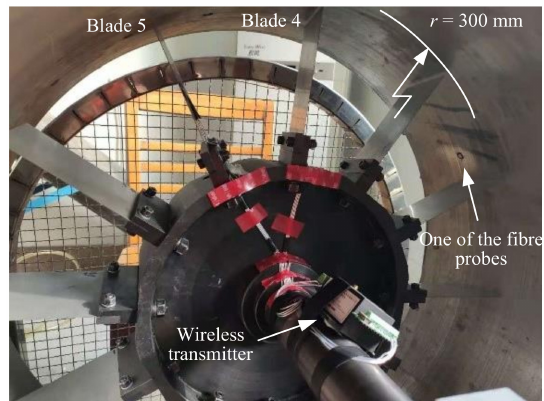
Figure 7. BTT test rig with wireless strain gauges.